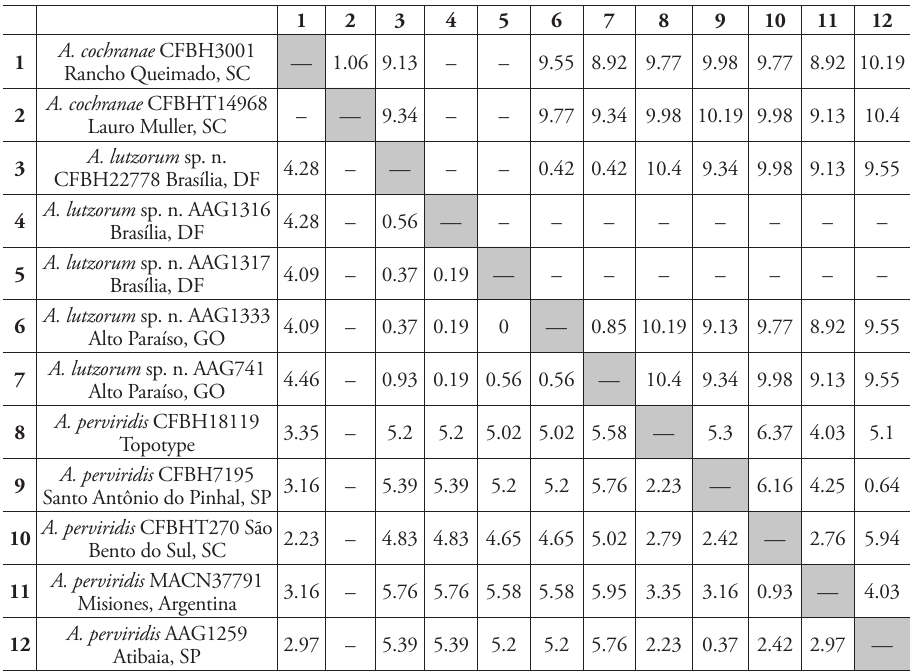
Table 3. Uncorrected pairwise sequence distances (p-distances) of the Cytochrome c oxidase subunit 1 (above the diagonal) and 16s fragments (below the diagonal) for the species of the Aplastodiscus perviridis species Group. See the Material and methods section for the primers that delimitate each fragment. Values are in